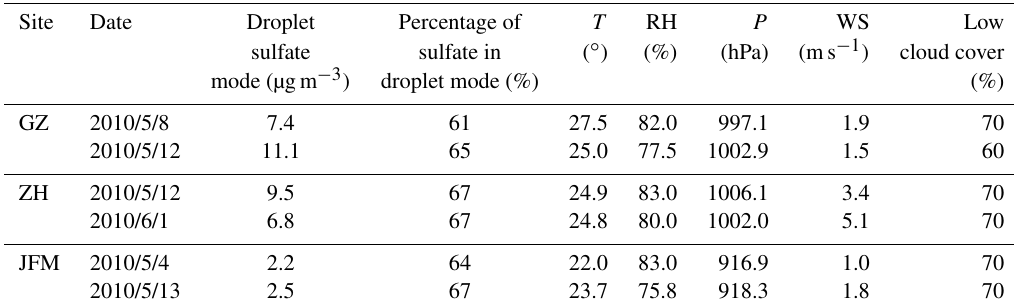
Table 2. Statistical parameters of samples with air masses from